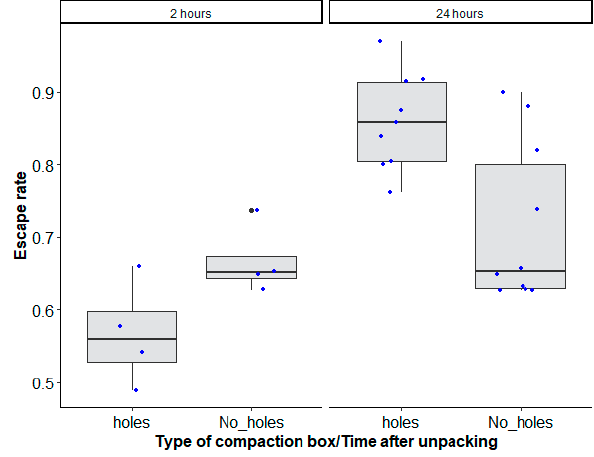
Figure 4. Aedes aegypti , Senegal strain, escape rates according to the type of mosquito compaction square box with holes (‘holes’) and without holes (‘No_ holes’), and time after unpacking (2 h and 24 h recovery times). Black bars indicate the median. The upper and lower limits of each box indicate the interquartile range. Each blue dot represents a value of the observed escape rate per replicate. Black dots represent outliers. Table 3. Fixed effects of the interaction between mosquito compaction box type (square with and without holes) and the duration of transport on Aedes aegypti , Senegal strain, survival rate (recovery rate) after long-distance transport.